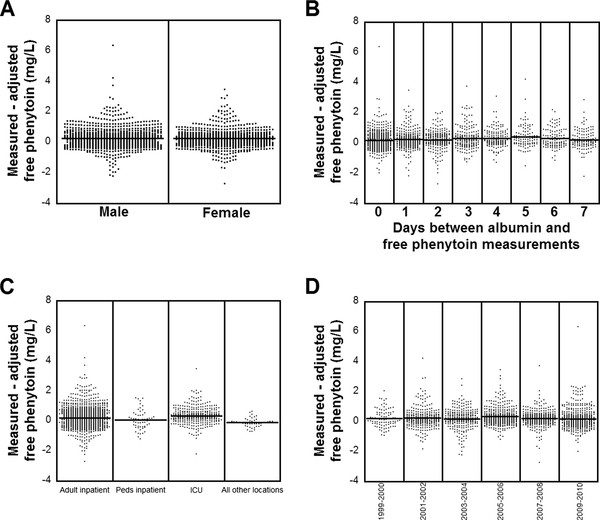
Variation of the difference of PHTfree and PHTadj_free with respect to various independent variables. (A) Distribution of the difference between PHTfree and PHTadj_free separated between males and females. Each dot represents a single timepoint of data with a total of 1,020 datapoints from male patients and 733 datapoints from female patients. The solid horizontal lines indicate the mean difference. There was no significant difference between males and females (unpaired t-test > 0.05). (B) Distribution of the difference between PHTfree and PHTadj_free separated by the days in between the albumin and total phenytoin measurements (that allowed for PHTadj_free calculation). Each dot represents a single timepoint of data with a total of 1,753 datapoints (559 datapoints for 0 days difference between albumin and PHTtotal determination, 290 for 1 day difference, 215 for 2 days difference, 190 for 3 days difference, 152 for 4 days difference, 103 for 5 days difference, 112 for 6 days difference, and 132 for 7 days difference). The solid horizontal lines indicate the mean difference. There was no significant difference across days between albumin and phenytoin measurements (ANOVA P value > 0.05). (C) Distribution of the difference between PHTfree and PHTadj_free separated into categories of patient location at time of laboratory ordering of PHTtotal and PHTfree. 'Adult inpatient' and 'Peds inpatient' encompass all inpatient locations excluding intensive care units (ICUs), with adult defined as age 15 or older. 'All other locations' encompasses outpatient clinics, emergency room, and scheduled draws at hospital phlebotomy stations. (D) Distribution of the difference between PHTfree and PHTadj_free separated into years in which the laboratory measurements were performed. There was a significant effect of patient location at time of PHT measurements (ANOVA P value < 0.0001)